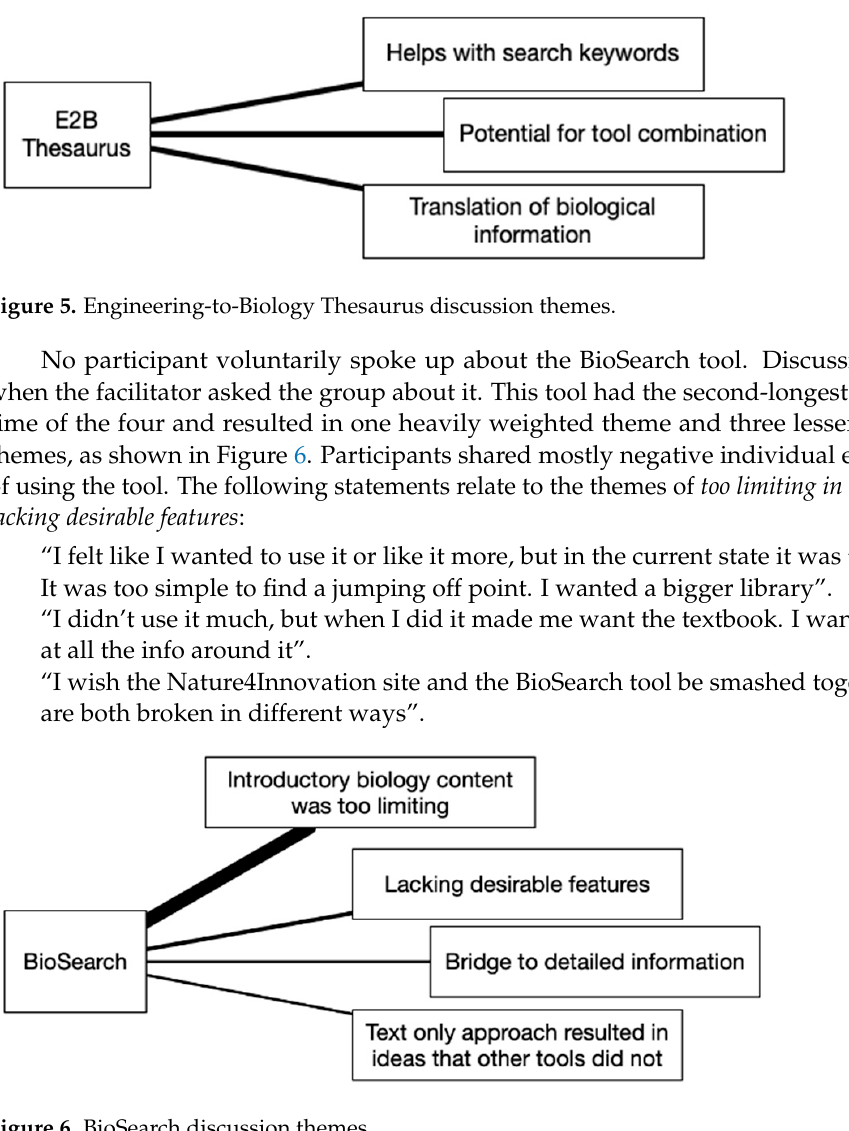
Figure 6. BioSearch discussion themes.